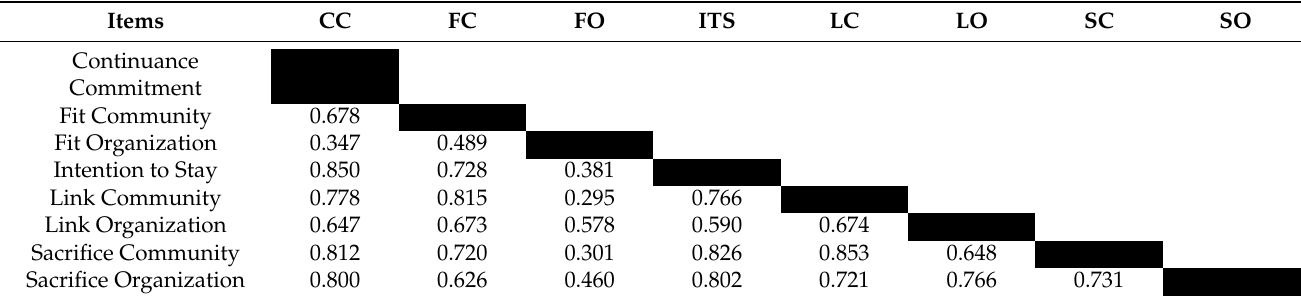
Table 4. Discriminant validity results based on the heterotrait-monotrait ratio of correlations (HTMT).